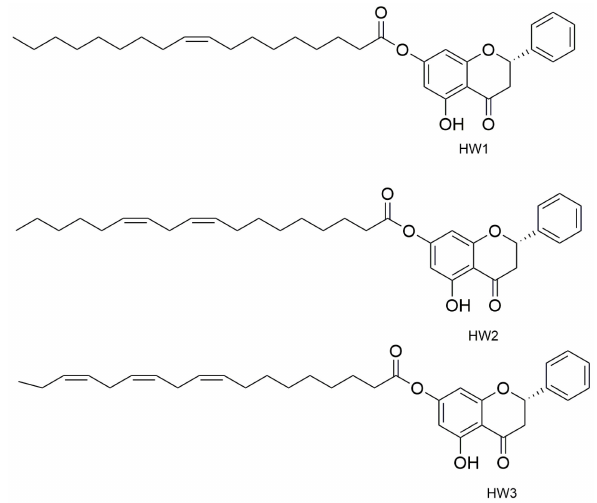
Figure 3. Pinocembrin’s